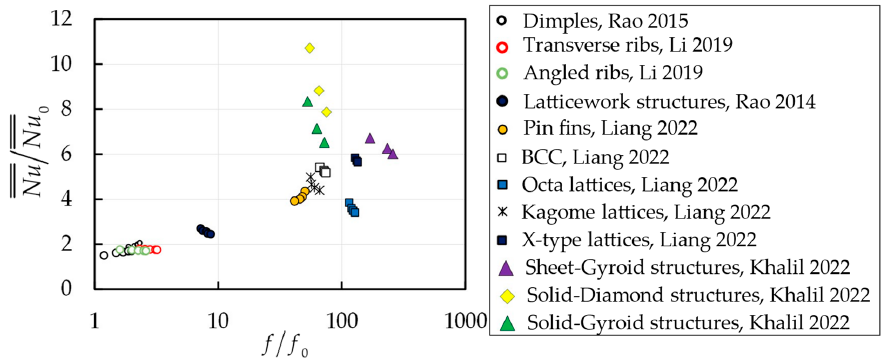
Figure 21 . Comparisons of relative thermal performance for different cooling strategies. Dimples [86], Transverse ribs [87], Angled ribs [87], Latticework structures [88], Pin fins [13], BCC [13], Octa lattices [13], Kagome lattices [13], X-type lattices [13], Solid-Diamond structures [48], Sheet-Gyroid